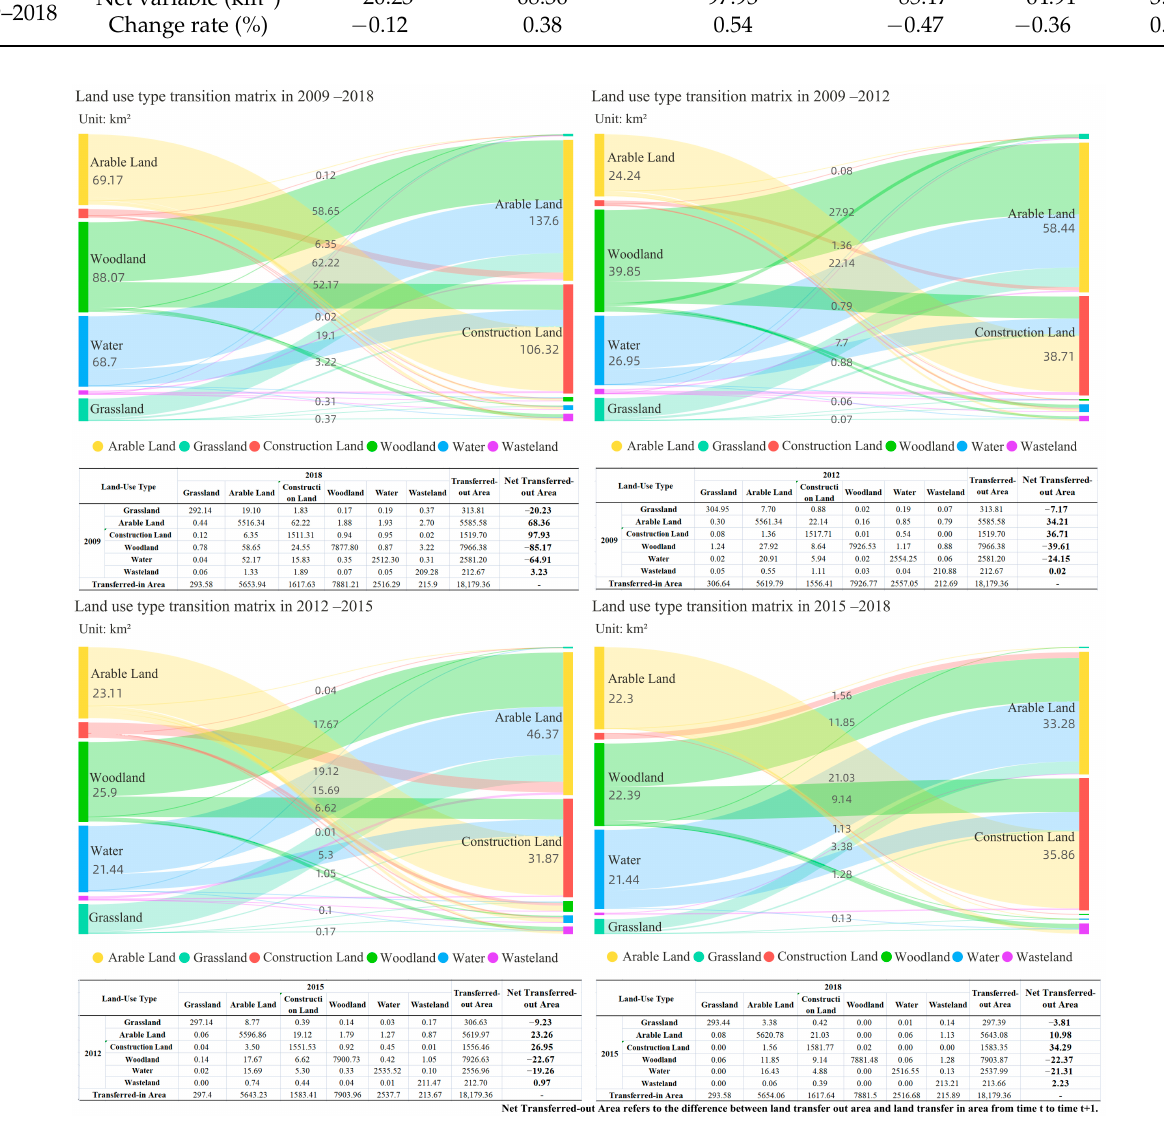
Figure 3. Sankey Diagram of Land Use Type Transfer Matrix of Changde from 2009 to 2018.